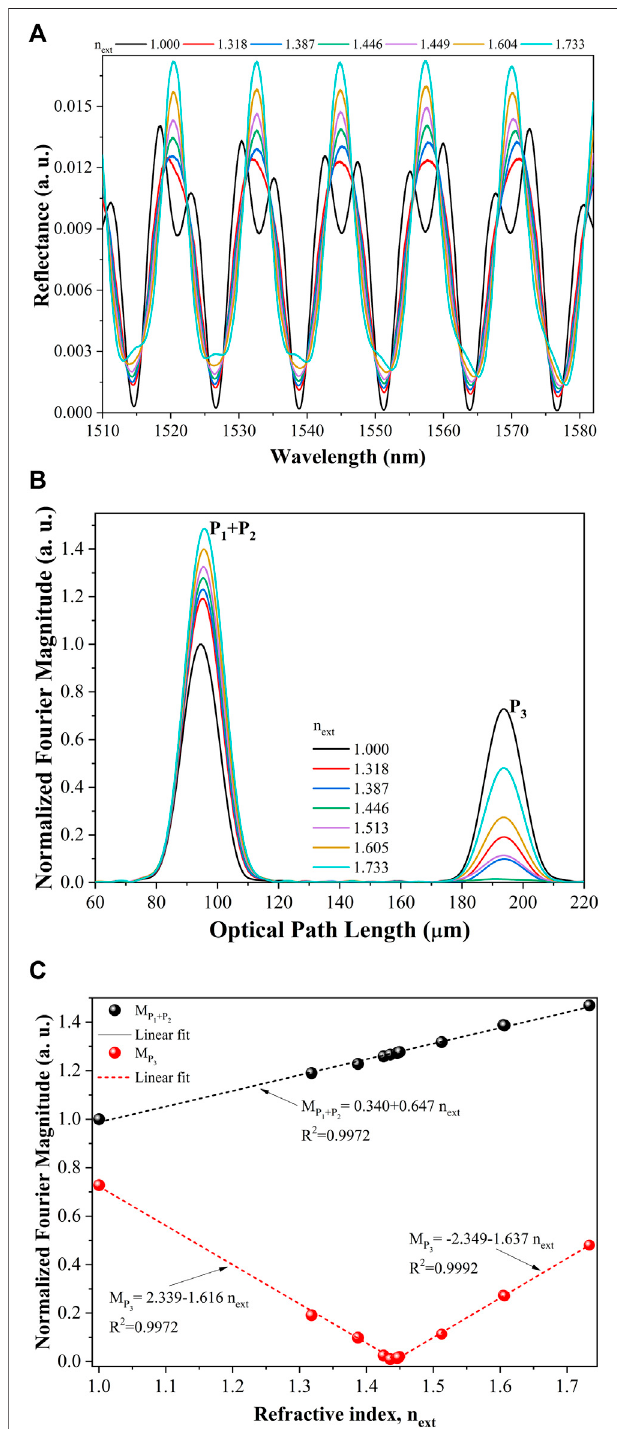
FIGURE 5 | (A) Experimental spectra of the optical re fl ectance and (B) the corresponding Fourier transform. (C) Changes in the magnitude of the Fourier spectra peak when the i-HFFPI was immersed in different Cargille